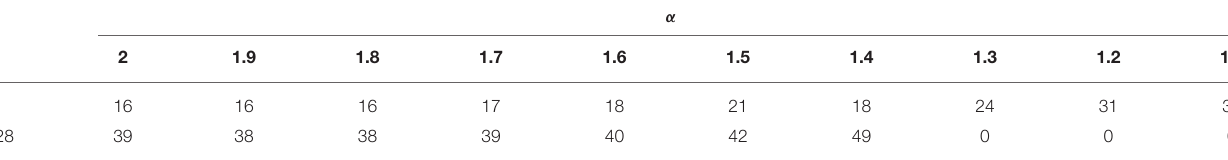
The mark–means no sustained propagation. TABLE 2 | Values of VW (ms) measured for several test values of γ after applying the S1–S2 cross-filed stimulation protocol to the